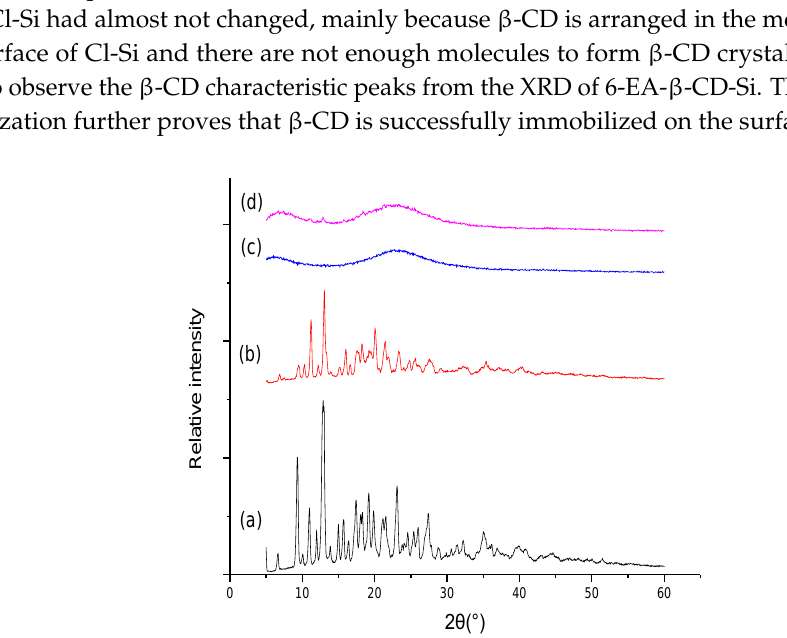
Figure 1. Fourier transform infrared (FT-IR) spectra of β-CD (a), 6-EA-β-CD (b), Cl-Si (c), and 6-EA- β-CD-Si (d).